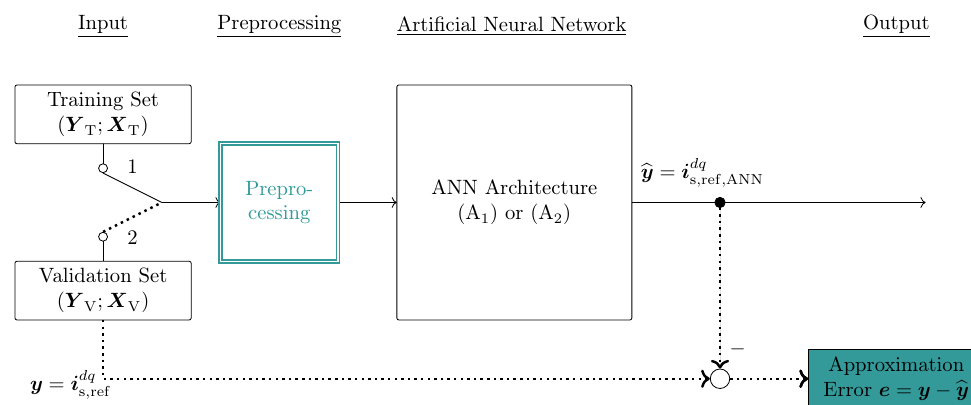
Figure 10. Illustration of ANN training and validation procedure, training set and validation set, re- spectively: Approximation error e : = y between the numerically computed optimal reference currents and the ANN